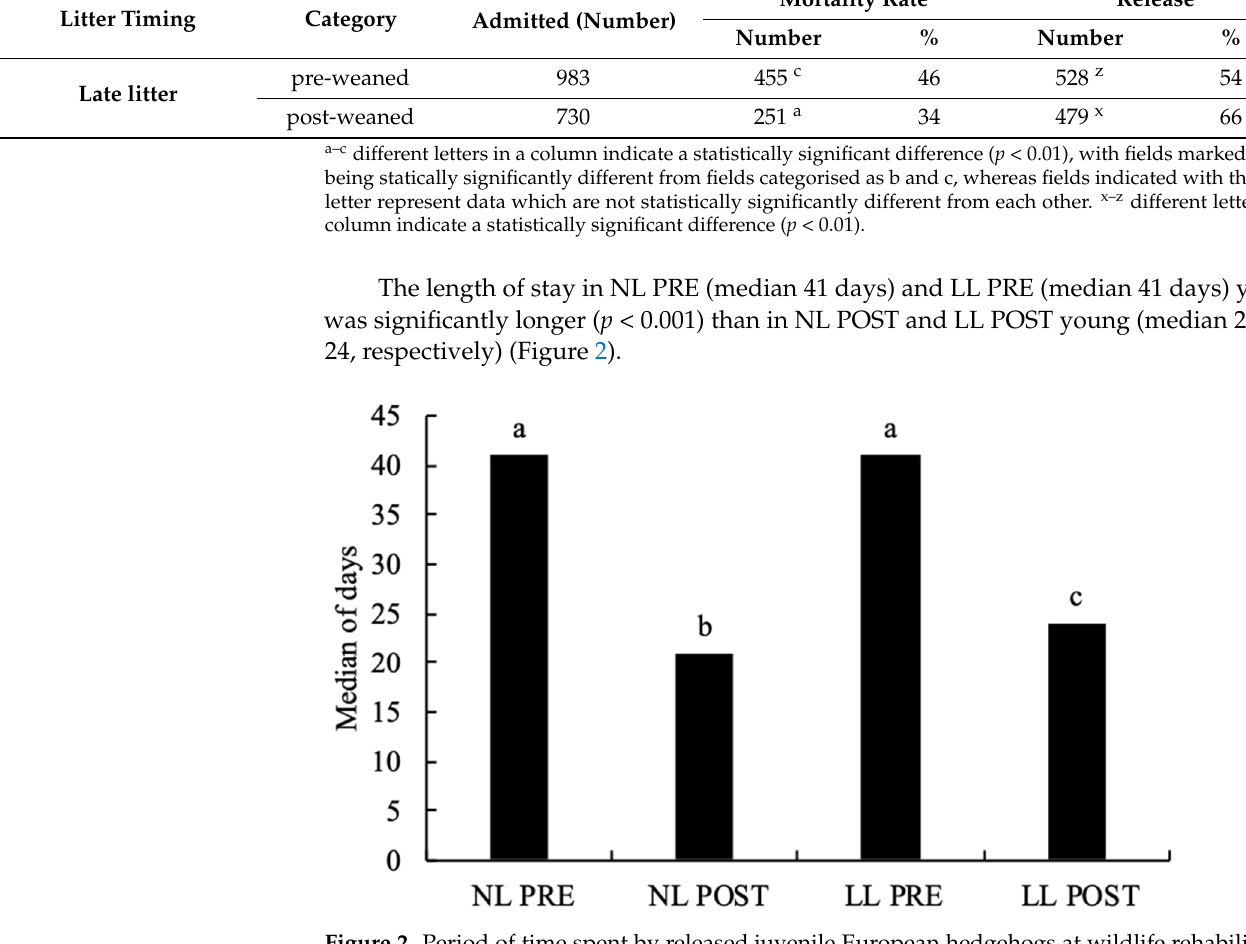
Figure 2. Period of time spent by released juvenile European hedgehogs at wildlife rehabilitation centres in the Czech Republic from 2011 to 2020 divided into four categories by weight and timing of litter (data are from the 3441 individuals with known outcome). Note: columns or bars with different letters (i.e., a versus b, a versus c, b versus c) indicate that they are statistically different from each other, while those with same letters (c versus c) indicate that they are not statistically different from each other. NL PRE = pre-weaned juvenile hedgehogs from normally timed litters (n = 806); NL POST = post-weaned juvenile hedgehogs from normally timed litters (n = 151); LL PRE = pre-weaned juvenile hedgehogs from late litters (n = 525); LL POST = post-weaned juvenile hedgehogs from late litters (n =